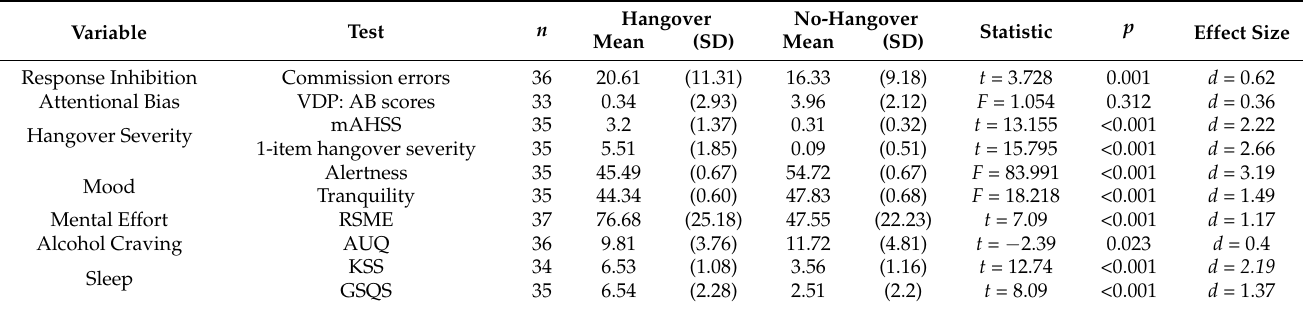
Table 2. Descriptive statistics for the cognitive tasks and questionnaires in the hangover and no-hangover conditions.